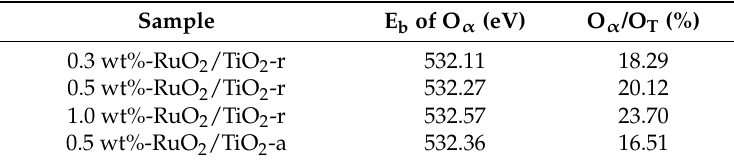
Table 1. Chemisorbed oxygen (O α ) in the RuO 2 /TiO 2 catalysts.